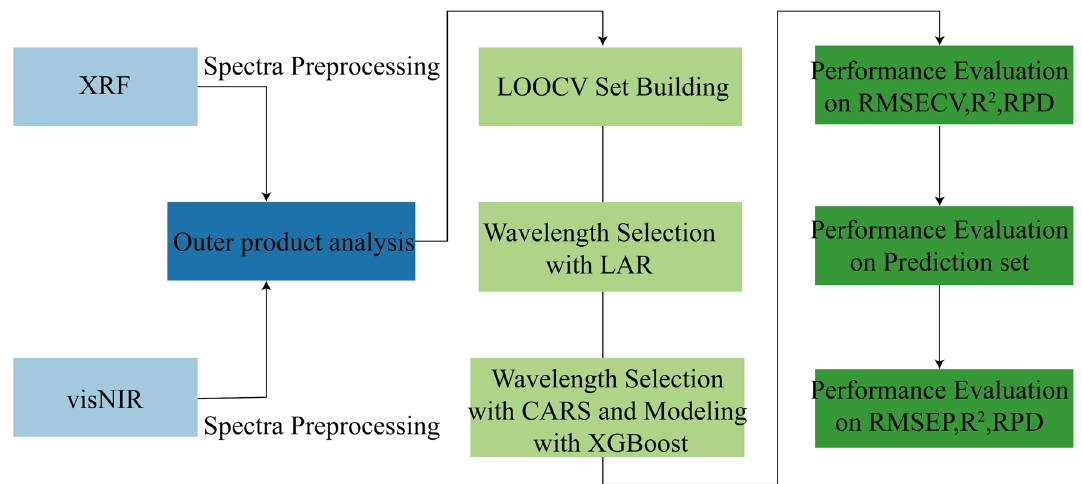
Figure 4. The Flow chart of proposed variable selection method by LAR-CARS.